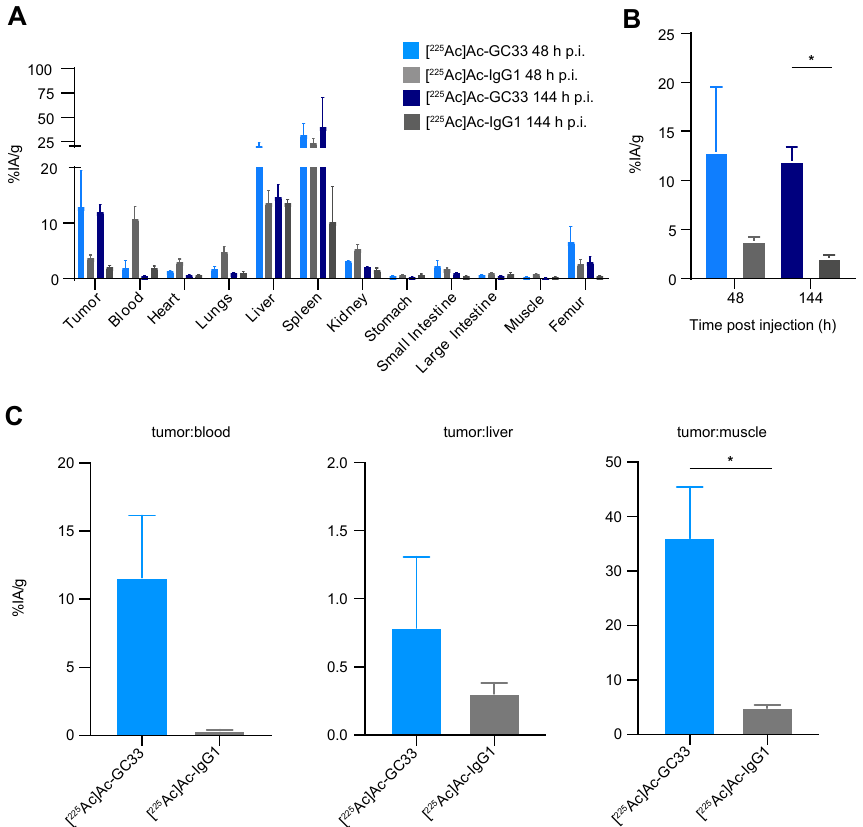
Figure 2. [ 225 Ac]Ac–GC33 specifically localizes to HepG2 tumors. ( A ). Biodistribution studies show notable accumulation of either radioconjugate in spleen, liver, and tumor tissues in the HepG2 tumor model. ( B ). [ 225 Ac]Ac–GC33 demonstrates preferential tumor uptake in the HepG2 tumor model at 144 h p.i. compared to [ 225 Ac]Ac–IgG1 ( p = 0.0120), but not at 48 h p.i. ( p = 0.2415) ( C ). There are quantitatively higher tumor:blood and tumor:liver ratios in animals receiving [ 225 Ac]Ac– GC33, with tumor:muscle ratios significantly higher for animals given [ 225 Ac]Ac–GC33 compared to [ 225 Ac]Ac–IgG1 ( p = 0.0304). Error bars represent the standard error of the mean (SEM). Statisti- cal significance was defined by p < 0.05 (*).